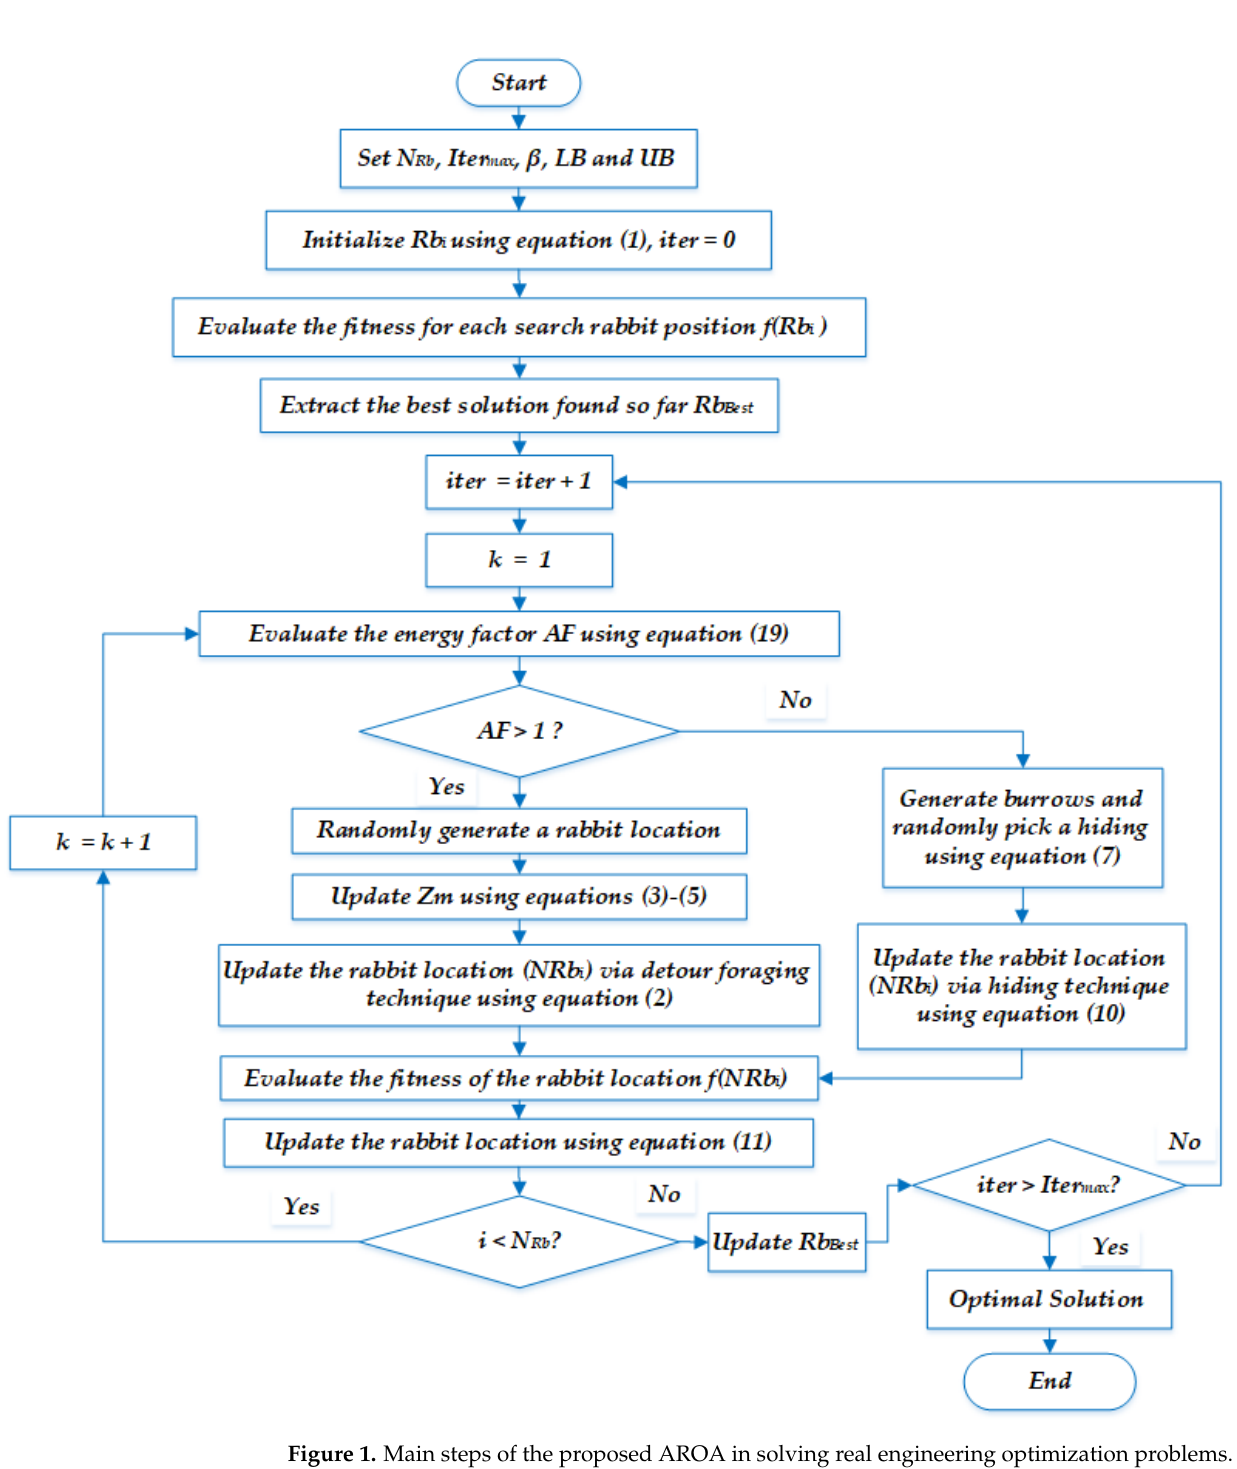
Figure 1. Main steps of the proposed AROA in solving real engineering optimization